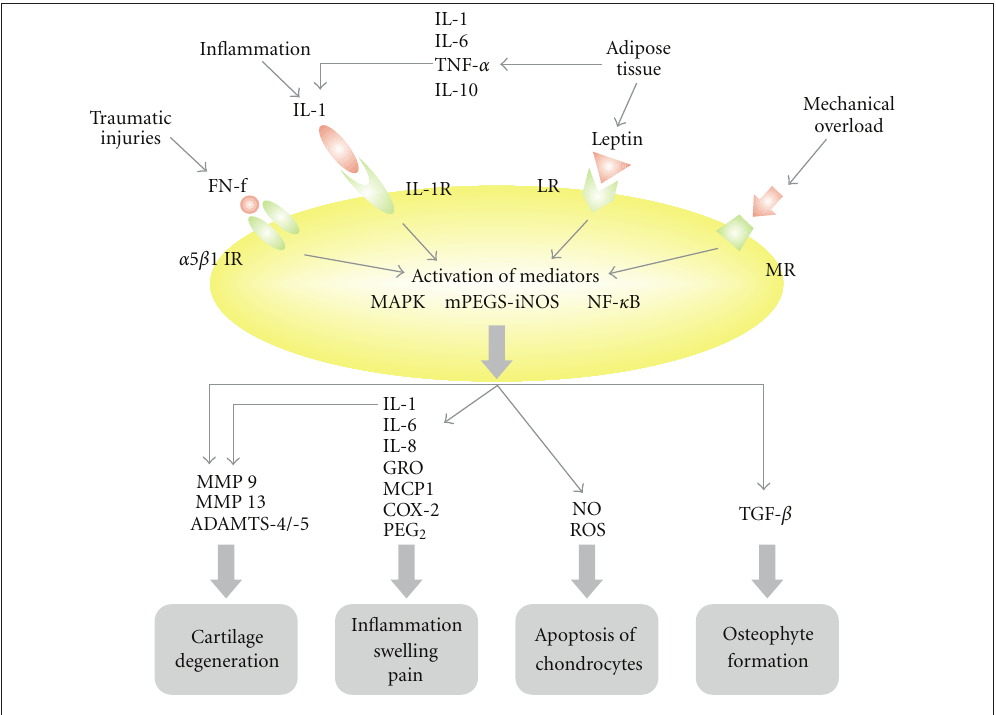
Figure 2: Inflammatory and oxidative processes involved in OA; FN-f: fibronectin fragment; IL-1 R: interleukin receptor; IR: integrin receptor; LR: leptin receptor; MR: